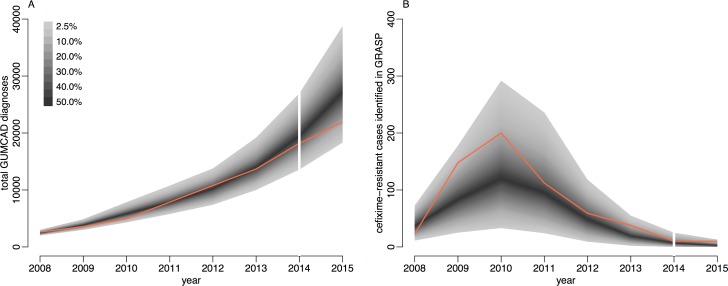
Comparison of simulated and observed cases of gonorrhoea.Panel A shows the total number of cases, and panel B shows only the cefixime-resistant cases. Observed data are shown in orange, with the shaded area showing the 95% posterior predictive interval (based on 1,000 simulations using samples from posterior distribution). Note different scales. GUMCAD, Genitourinary Medicine Clinic Activity Dataset.